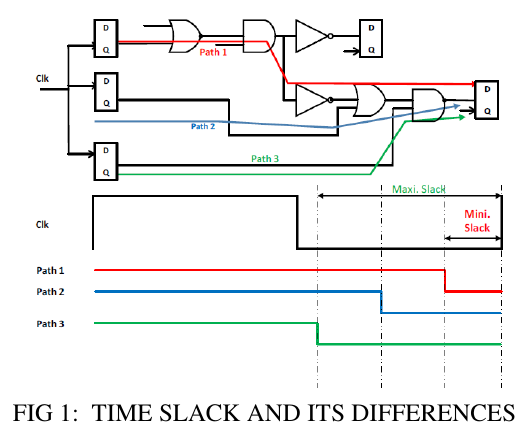
FIG 1: TIME SLACK AND ITS DIFFERENCES FOR SHORT PATHS AND LONGER